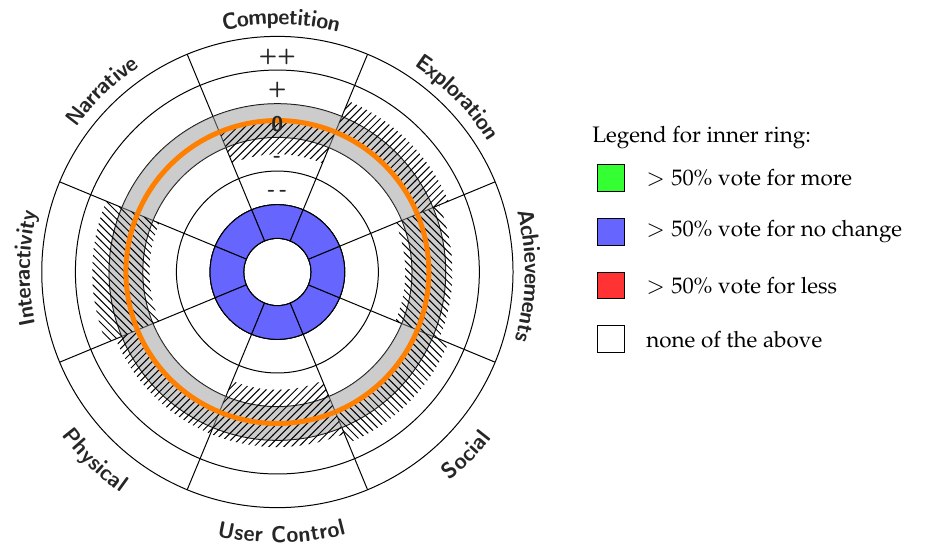
Figure 2. The Trekking Engagement Opinion Chart (24 participants) visualises the statistics from the tourists’ opinion. Hatches represent the area between the 10% and 90% percentiles; orange lines represent the